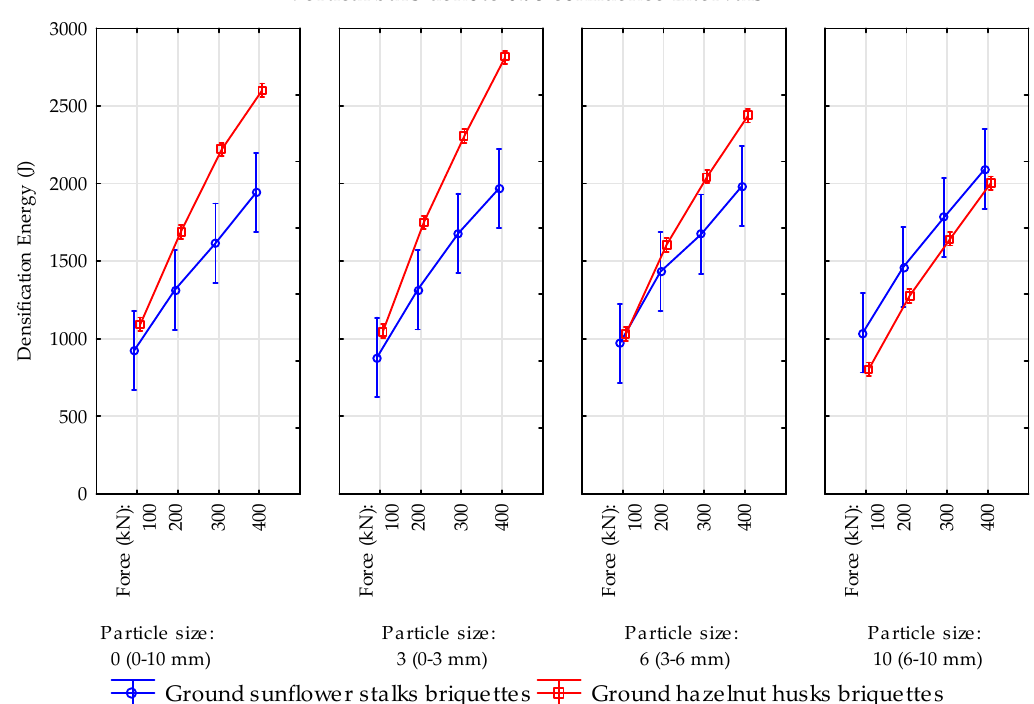
Figure 4. E ff ects of forces and particle sizes on briquette densification Figure 4. Effects of forces and particle sizes on briquette densification energy. Wilks lambda=0.04136, F(12, 22)=7.1818, p=0.00004 Vertical bars denote 0.95 confidence intervals